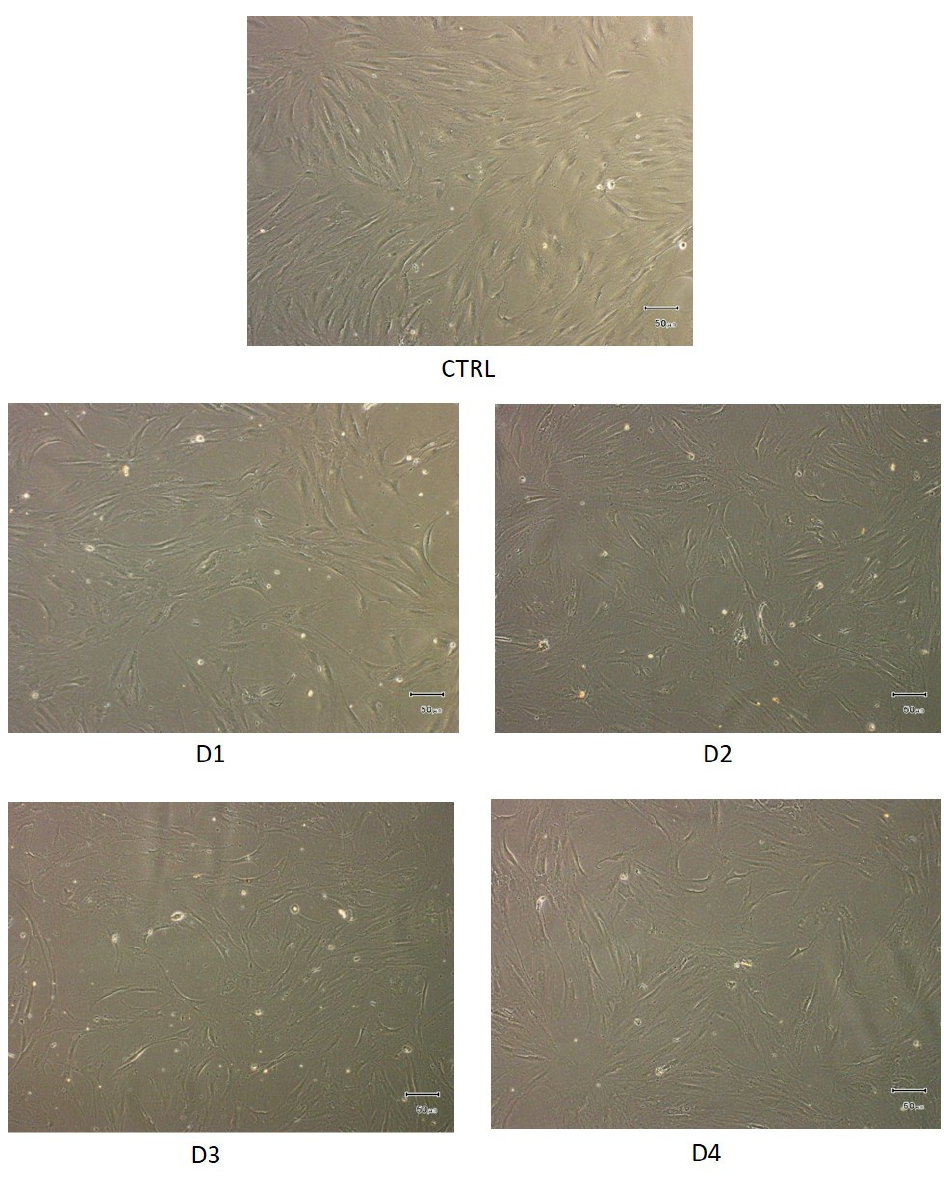
Figure 3. BFP-MSC morphology. Representative image of BFP-MSCs harvested from disks and re-plated. Images were taken by the Olympus DP20 microscope digital camera associated to a phase contrast inverted microscopy (magnification 100×).